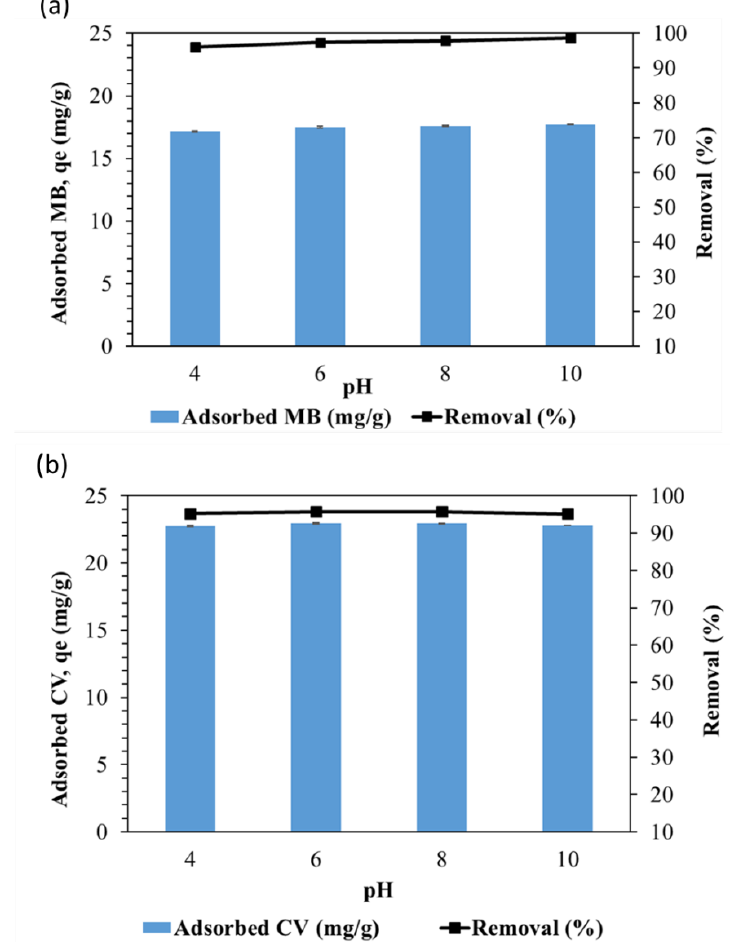
Figure 6. Influence of solution pH (4–10) on ( a ) methylene blue (MB) adsorption and ( b ) crystal violet (CV) adsorption.